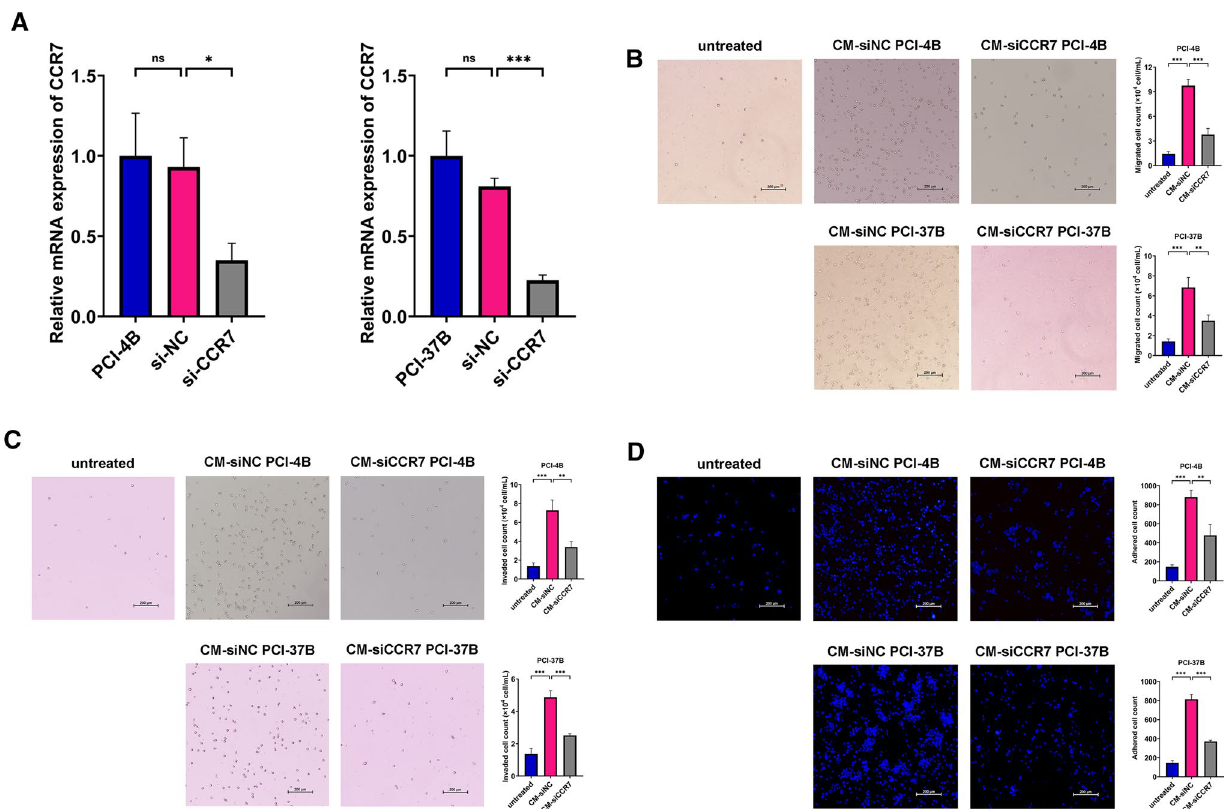
Fig. 2 CCR7 deficiency in OSCC cells restrained macrophage recruitment and adhesion. A qRT-PCR examining CCR7 knockdown efficiency in OSCC cell lines PCI-4B and PCI-37B. B The effects of OSCC CM on the migration ability of THP-1 cells were quantified by Transwell cell migration assay. Representative images and statistical analysis histograms were shown (scale bar: 200 μm). C The effects of OSCC CM on the invasion ability of THP-1 cells were estimated by Transwell cell invasion assay. Representative images and statistical analysis histograms were shown (scale bar: 200 μm). D The effects of OSCC CM on the adhesion of THP-1 cells assessed by cell adhesion assay. The nuclei were labelled with DAPI (blue). Representative images and statistical analysis histograms were shown (scale bar: 200um). The results are pre- sented as the mean ± SD, ns not significant, * P < 0.05, ** P < 0.01, *** P <